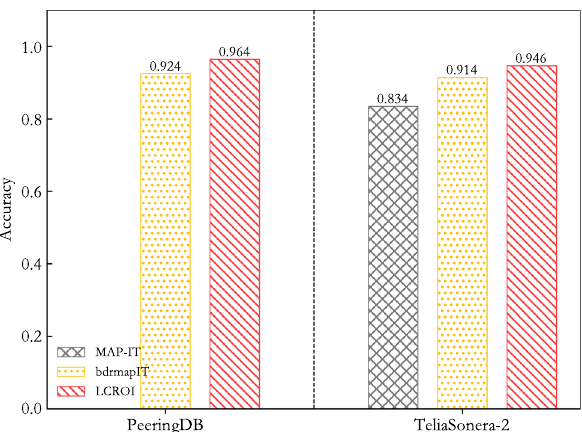
Figure 7. Comparison between LCROI and other methods using MIDAR 40 and iffinder 41 for alias resolution.